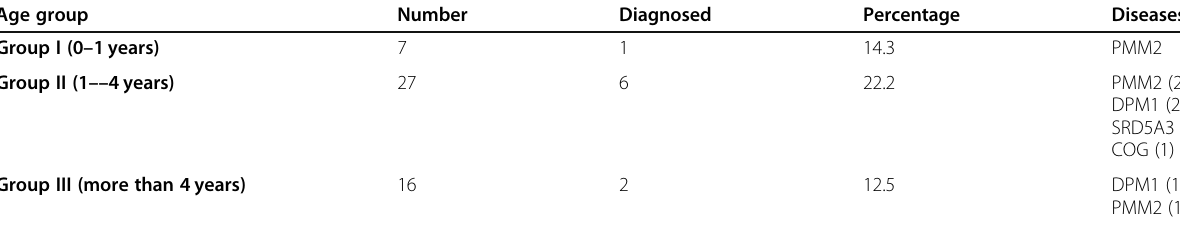
Table 4 Cases diagnosed according to the three age groups Age